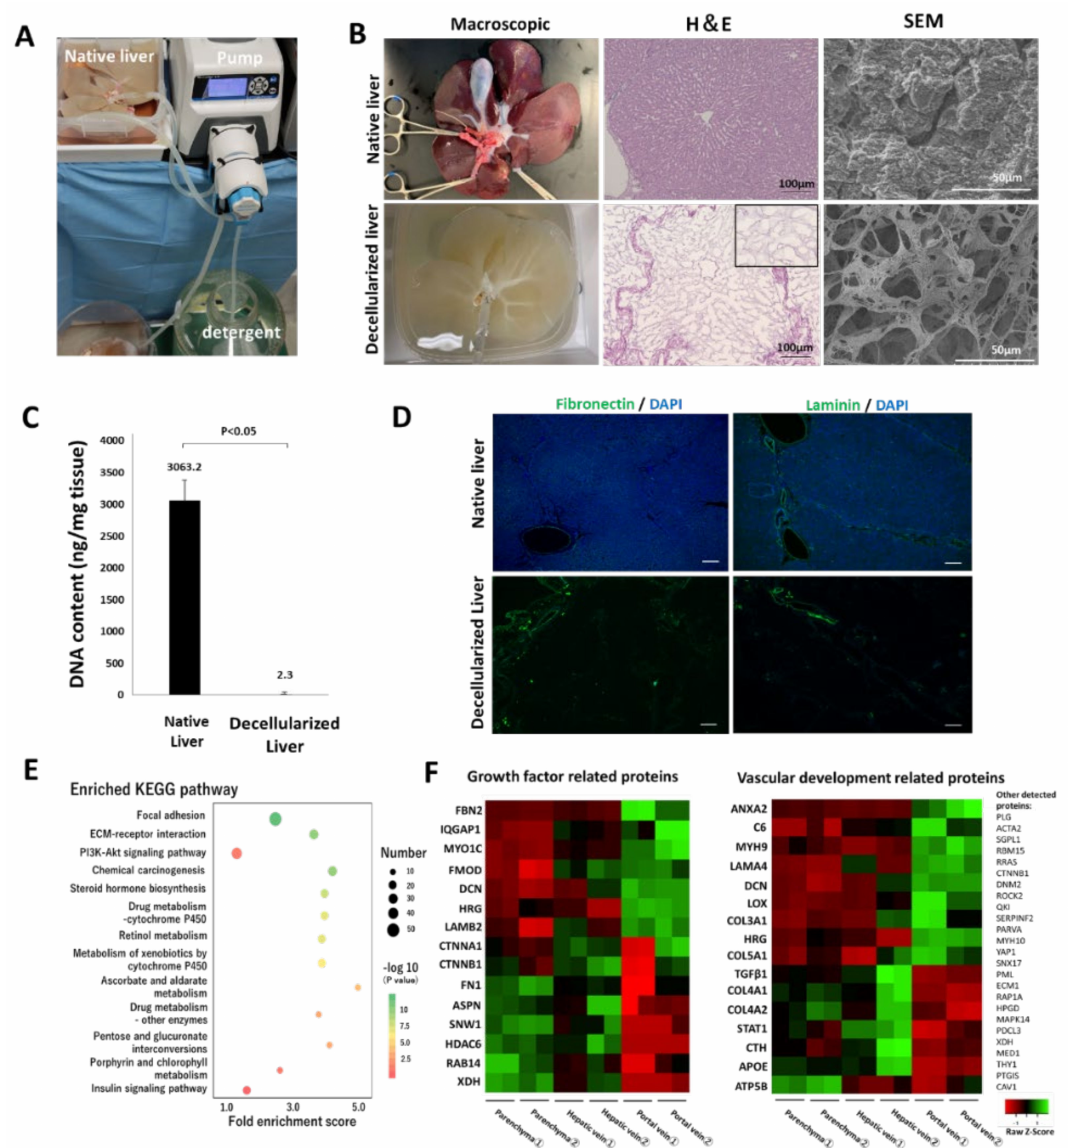
Figure 1. Decellularization of a whole porcine liver and properties of the decellularized scaffold. ( A ) Circulation system for the decellularization. ( B ) Comparison between the native and decellu- larized livers. Left to right: macroscopic appearance, H&E staining, high-power field SEM in the parenchymal space. In the H&E image, the black square shows a magnified view of the parenchymal space after the decellularization. ( C ) Residual DNA content in the native and decellularized porcine liver (mean ± SD, n = 4). ( D ) Immunostaining for the native and decellularized liver using anti- fibronectin and anti-laminin antibodies. Nuclei were counterstained with DAPI. Scale bar = 100 µ m. ( E ) Kyoto Encyclopedia of Genes and Genomes (KEGG) pathway analysis of the top 13 proteins with the greatest fold enrichment. X and Y axes denote the fold enrichment score on the KEGG pathway and the term of analyzed pathway, respectively. For the colored dots, the differences in color and size correpond to those in the p -value and the number of proteins assigned to each pathway. ( F ) Gene ontology enrichment analysis on proteins related to cell growth factors and vascular